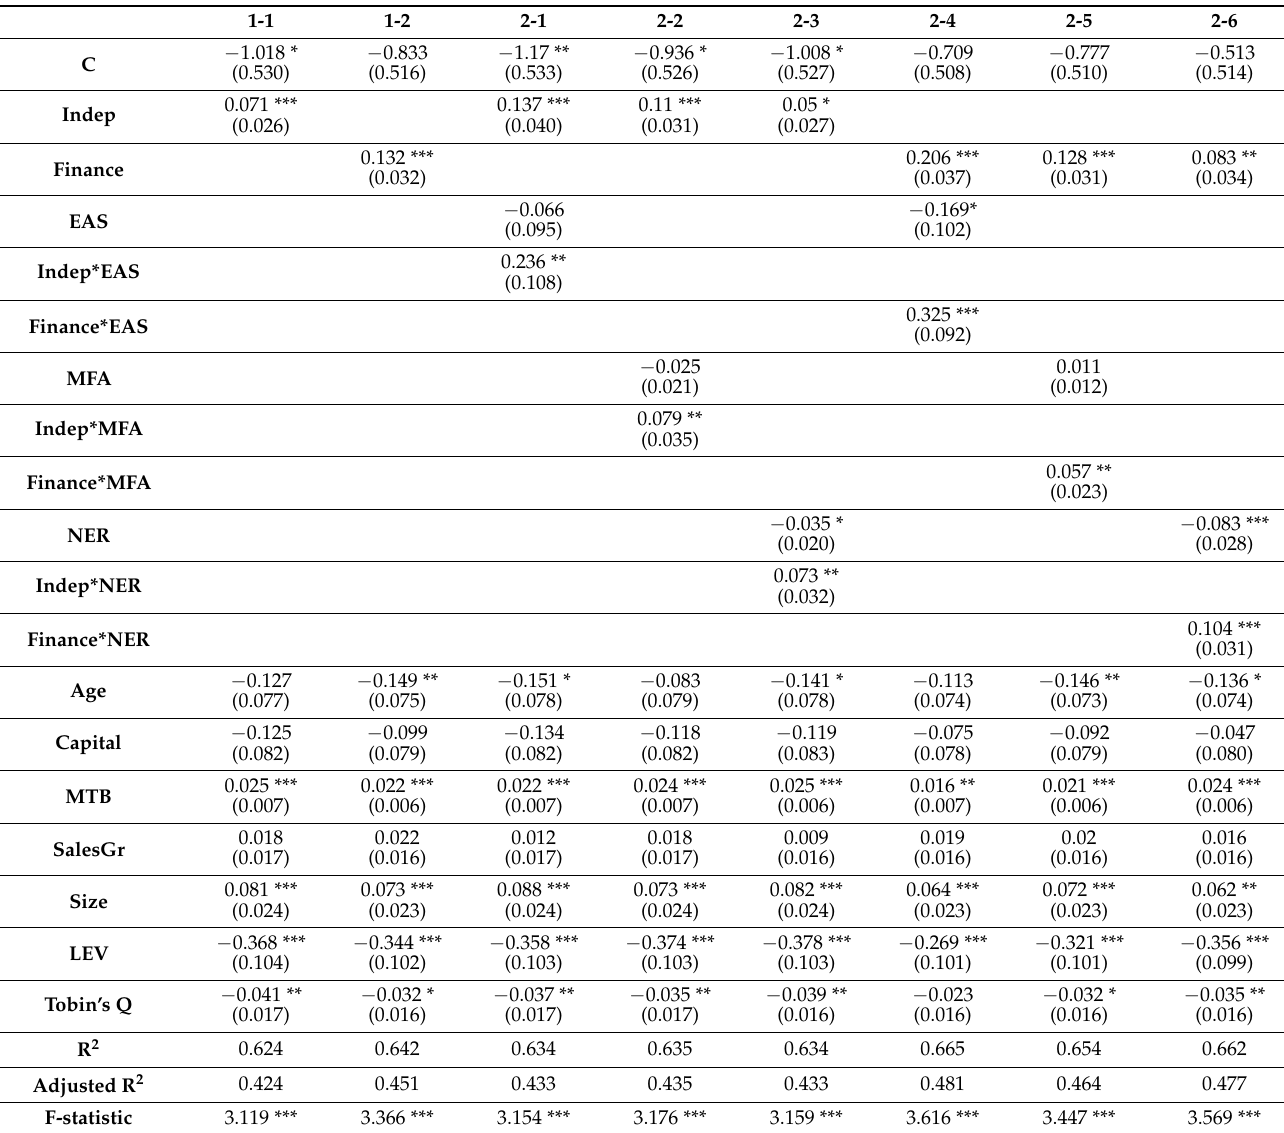
Table 5. Regression results for the high-level political